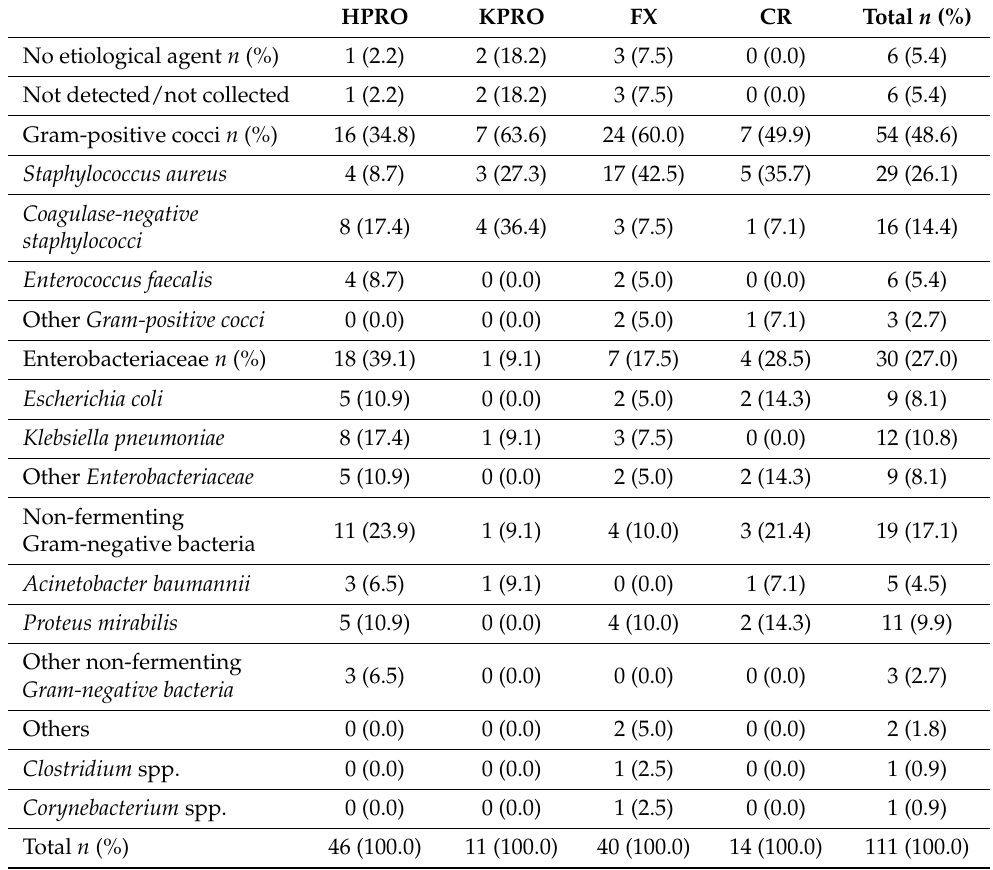
Table 4. Etiological agents of SSI-D in 2014–2018 in orthopaedic